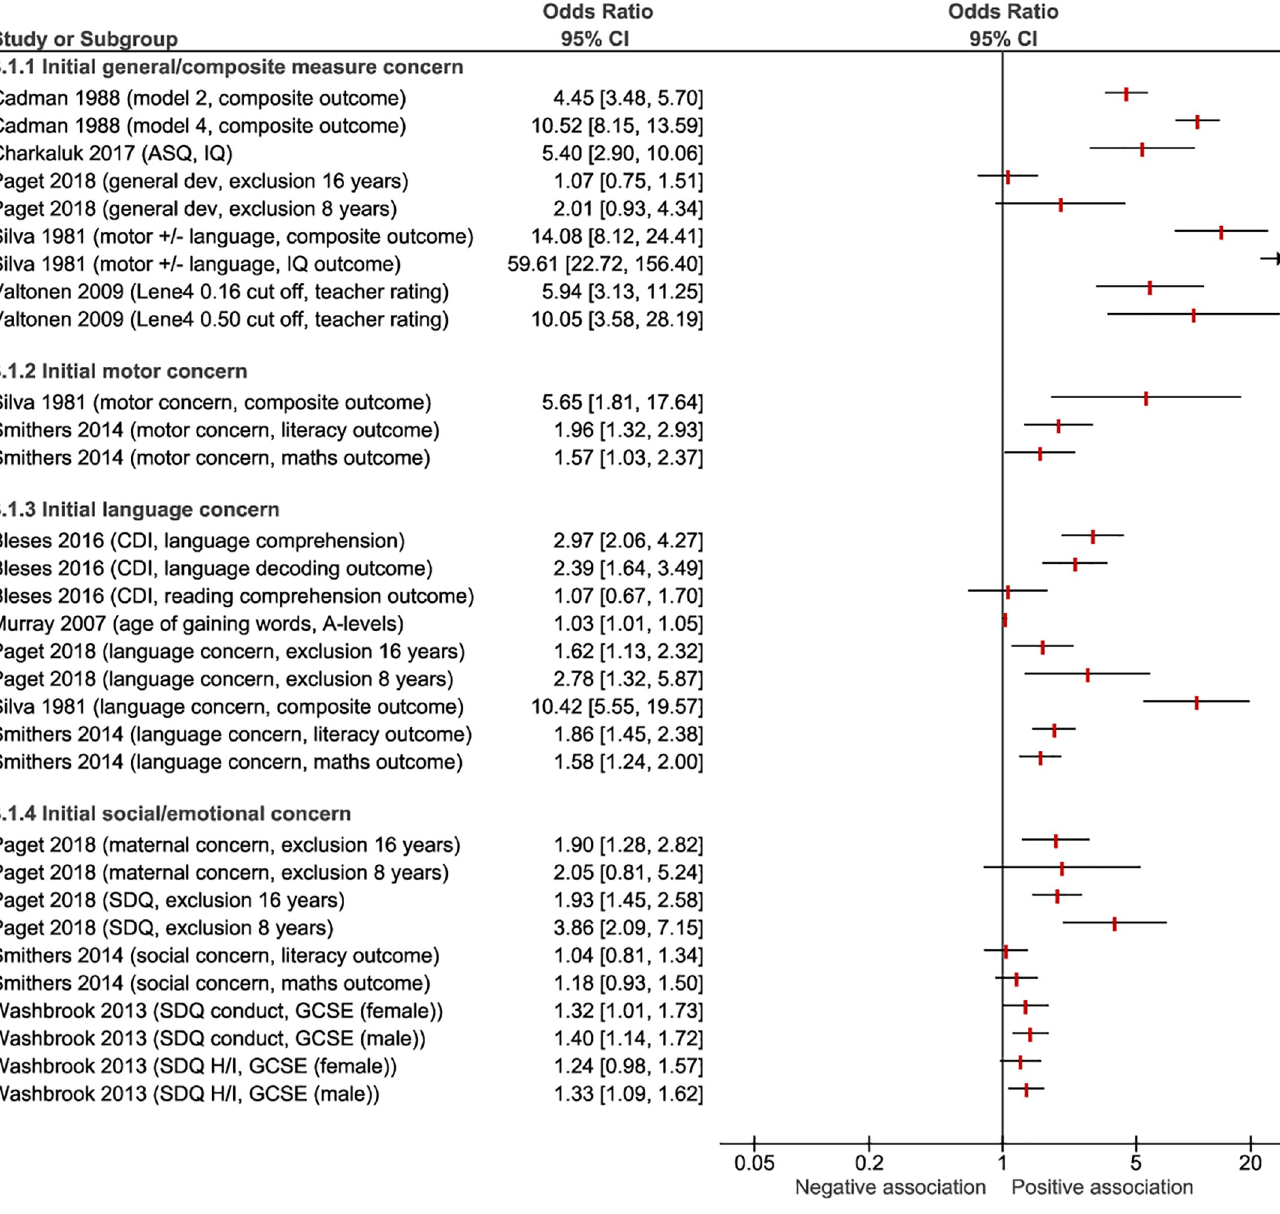
Fig 3. Forest plot of study diagnostic odds ratios grouped by developmental domain of the initial assessment. ASQ, Ages and Stages Questionnaire; CDI, The Danish Communicative Development Inventories; SDQ H/I, Strength and Difficulties Questionnaire Hyperactivity/Inattention score; GCSE, General Certificate of Secondary